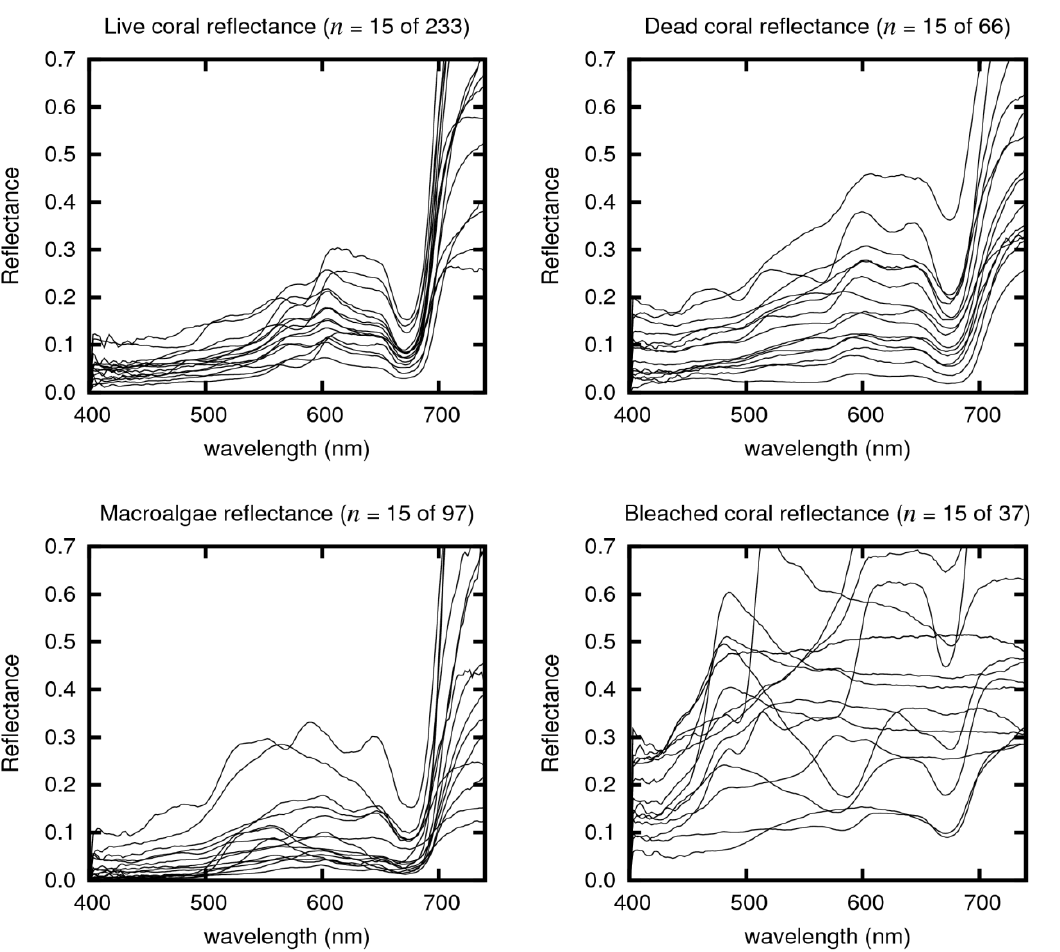
Figure 4. Benthic type in situ reflectances. For each type 15 spectral reflectances drawn at random from the full spectral library are